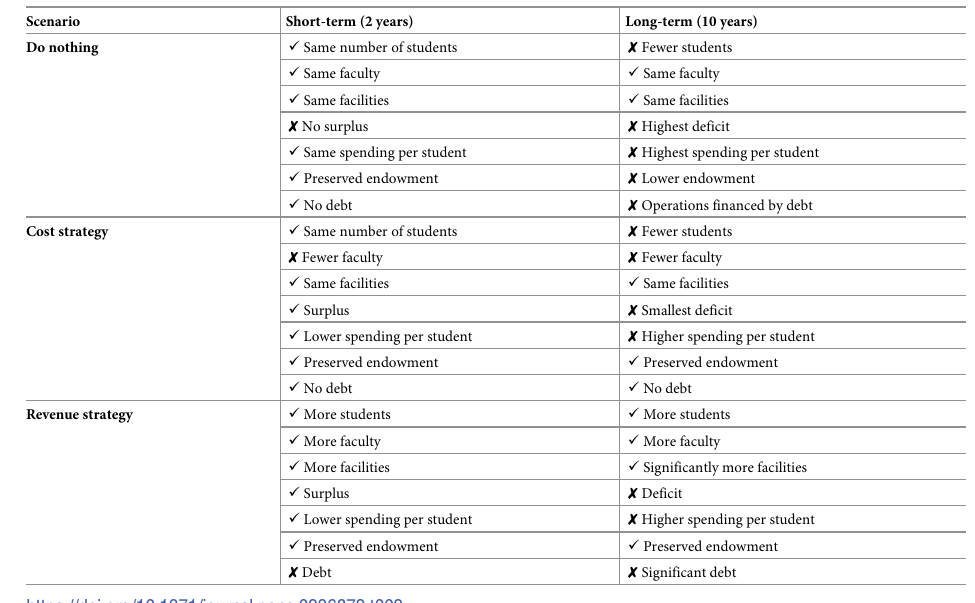
Table 2. Scenario highlights with pros ( ✓ ) and cons ( ✘ ).